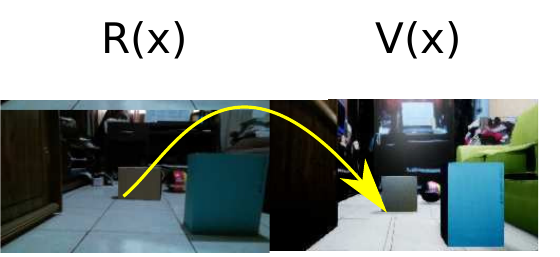
Figure 3. GAN’s domain change from a real environment to its virtual